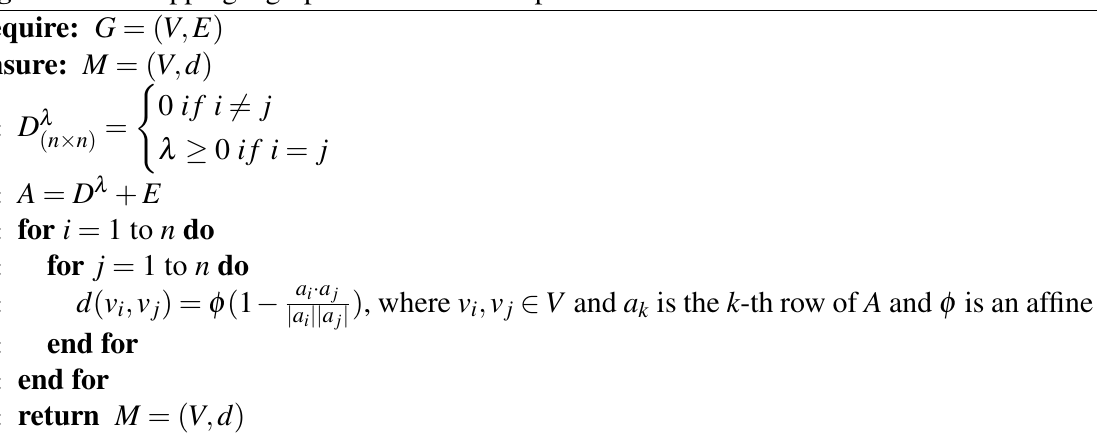
Algorithm 1 Mapping a graph into the metric